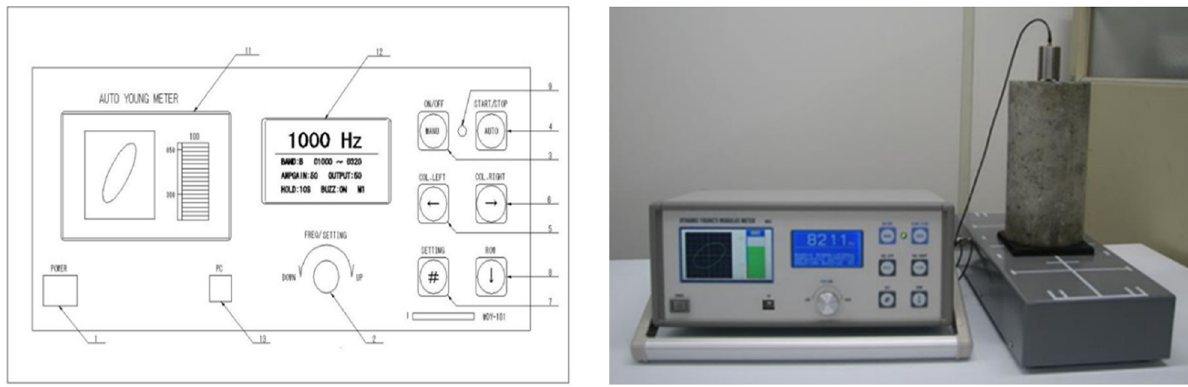
Figure 3: Dynamic Young ’ s modulus equipment.